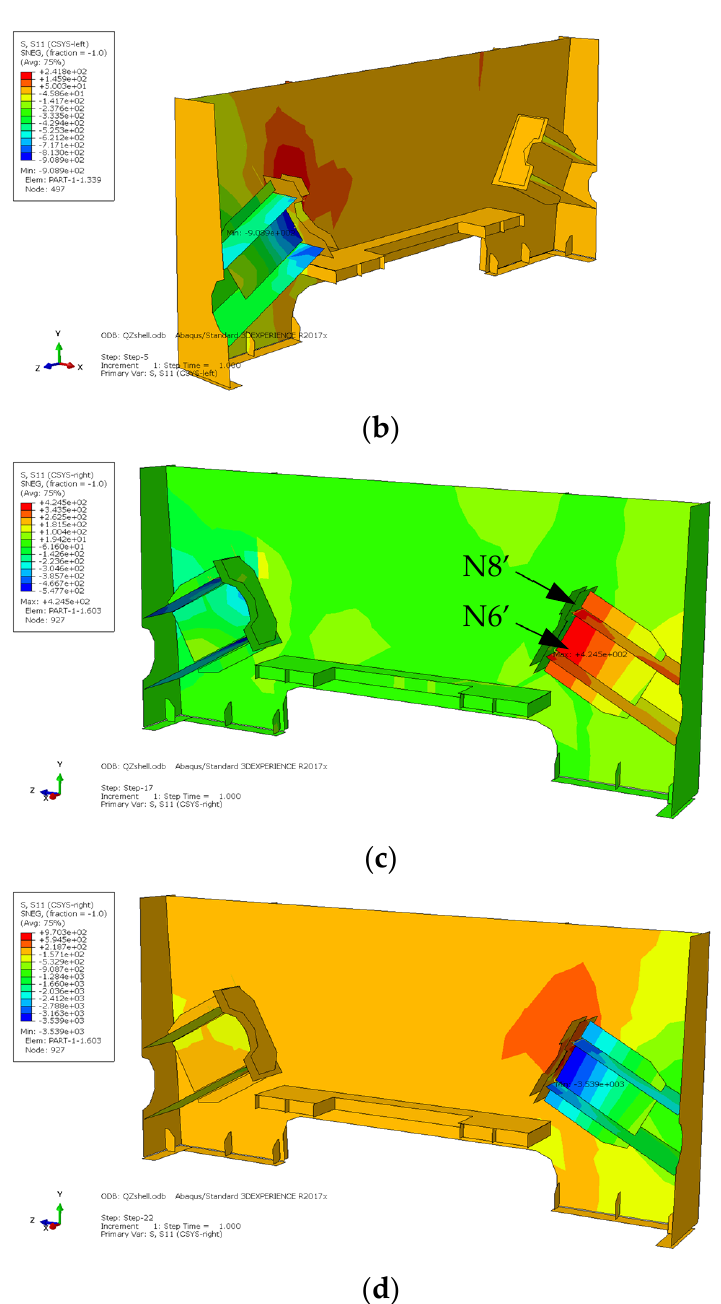
Figure 6. The distribution of maximum tensile and compressive stress of the steel anchor box. ( a ) Maximum tensile stress of the bearing structure at the end of cable 1. ( b ) Maximum compressive stress of the bearing structure at the end of cable 1. ( c ) Maximum tensile stress of the bearing structure at the end of cable 28. ( d ) Maximum compressive stress of the bearing structure at the end of cable 28. The stress history of the load-bearing structures at the ends of cable 1 and cable 28 extracted from the ABAQUS finite element model is shown in Figure